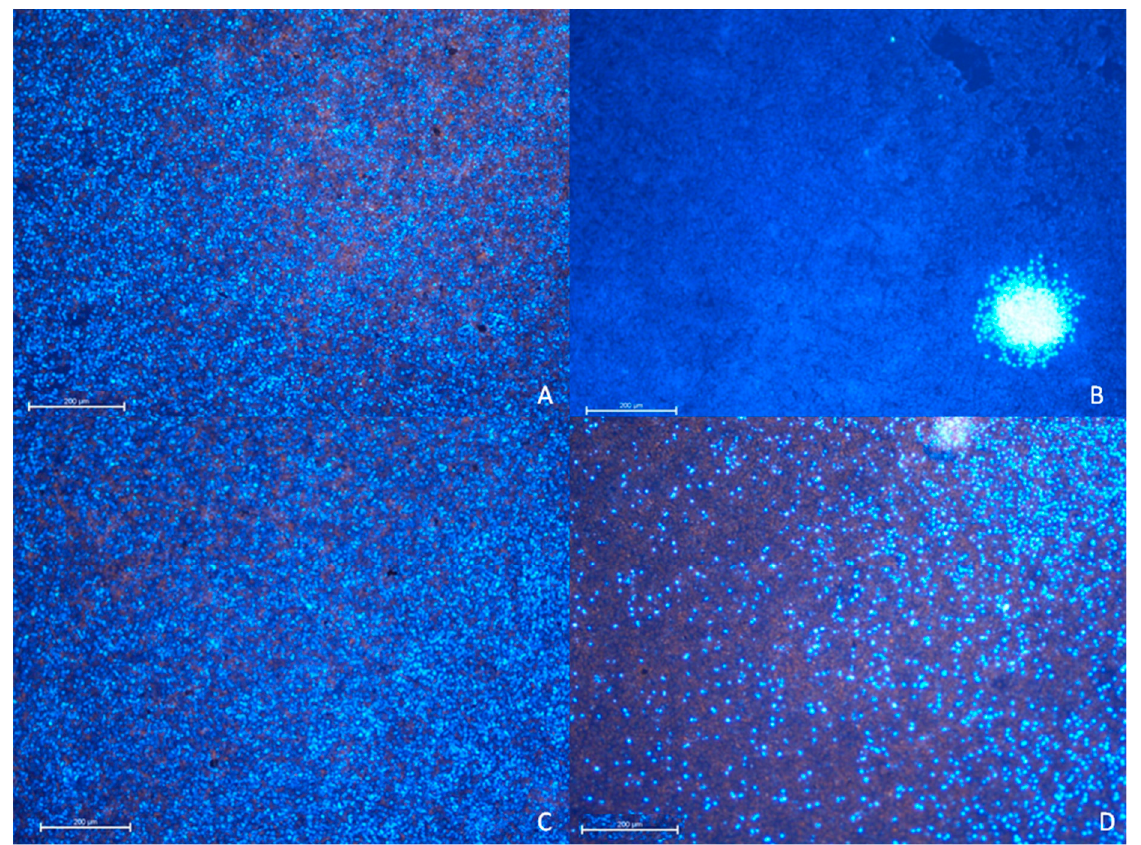
Figure 9. A549 (ATCC ‐ CCL ‐ 185TM) cell line 48 h after administration of virus and GO. ( A ) Control group, ( B ) group RuV, ( C ) GO group, ( D ) GO + RuV group. Different ability of DAPI uptake (blue dots) by cells. In RuV48 group visible arrangement of surviving cell in a colony manner. Other cells showed cytopathic effect. In other GO groups, visible similar level of responding cells in comparison to the control group. In GO + RuV group about 50% of cells are not responding due to virus infestation. DAPI and Rhodamine B. Mag 40x. Scale bar 200 μ m.